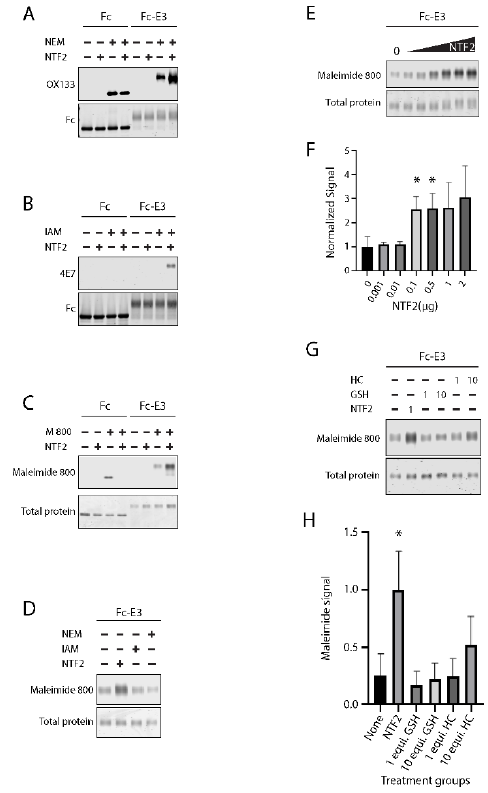
Figure 1. Detection of thiol groups in NOTCH3 after exposure to NTF2. ( A ) Fc protein or Fc-fusion to EGF-like domains 1–3 of human NOTCH3 (Fc-E3; 300 ng) were incubated with 0 or 2 µ g NTF2 (5 µ L reaction in PBS) followed by 5 mM N-ethylmaleimide (NEM; final volume 10 µ L) and Western blotted using OX133 to assess for trans-reduction of disulfides in Fc-E3 in the presence of NTF2 (upper panel). Immunoblot for Fc on the same blot was used to control for protein loading (lower panel). ( B ) Free thiols induced by NTF2 were also measured by reaction with iodoacetamide (IAM) followed by detection of alkylated cysteines with 4E7 (upper panel); initial reaction was 5 µ L and final volume after labeling was 10 µ L. Control for protein loading among Fc or Fc-E3 was performed by immunoblotting for Fc on the same blot (lower panel). ( C ) Fc or Fc-E3 treated with NTF2 were labeled with maleimide dye (M 800 or Maleimide 800) to reveal the degree of cysteine reduction induced by NTF2 (upper panel); initial reaction was 5 µ L and final volume after labeling was 15 µ L). Simply Blue (Invitrogen) total protein stain was used to control for protein loading (lower panel); ( D ) effect of cysteine alkylation on maleimide 800 labeling after NTF2 trans-reduction. Preincubation of Fc-E3 with IAM or NEM (3 µ L reaction) was followed by 2 µ g NTF2 treatment (addition of 2 µ L), followed by maleimide dye labeling (addition of 10 µ L) which was detected by gel scanning (upper panel). Protein loading was controlled by Simply Blue staining after gel scanning (lower panel). ( E ) Dose dependency of NTF2 on trans-reduction. Increasing amounts of NTF2 (0, 0.001, 0.01, 0.1, 0.5, 1, 2 µ g) were mixed with Fc-E3 protein (300 ng; all in 5 µ L reactions), followed by addition of a 20-fold molar excess of maleimide dye (addition of 10 µ L) and gel scanning (upper panel) followed by Simply Blue staining (lower panel); quantification of replicate experiments shown in ( F ). ( G ) Comparison of NTF2 trans-reduction capacity against biological reductants homocysteine (HC) and glutathione (GSH). Equimolar (1; relative to NTF2 used at 570 µ M) or 10-fold excess (10; 5.7 mM) of each biological reductant was mixed with Fc-E3 and then reacted with maleimide dye, detected by gel scanning (upper panel). Reaction volumes were 5 µ L in PBS followed by 10 µ L of labeling mix in PBS. Total protein loading for each sample is shown using Simply Blue staining (lower panel). ( H ) A comparison of Fc-E3 trans-reduction by NTF2 and 1 or 10 equimolar concentrations of GSH and HC are shown in the plot (NTF2 * p < 0.05). All experiments were replicated at least three